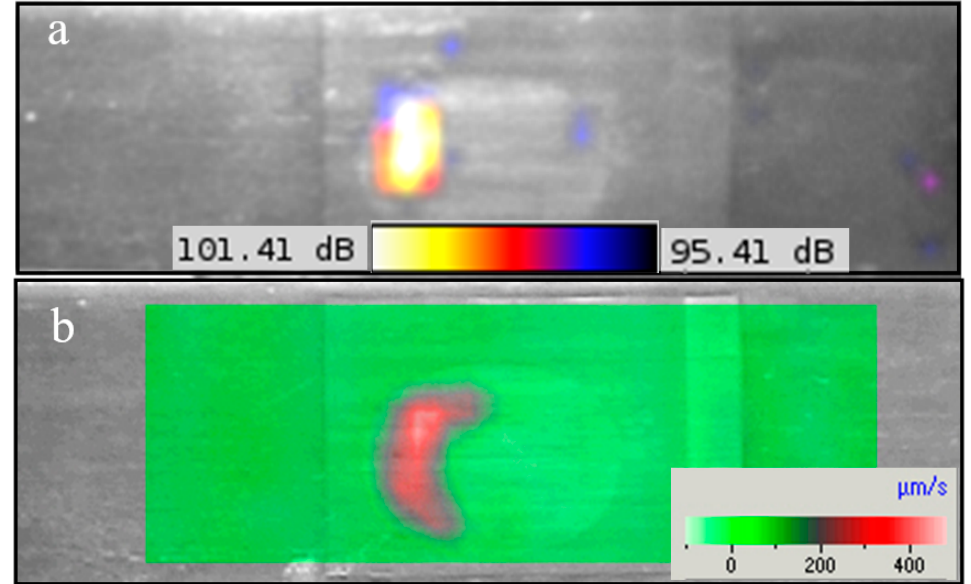
Figure 21. Soundcam imaging of a delamination in piezo-actuator imbedded in GFRP plate ( a ), 18,900 Hz LDR laser vi- brometry image of the delamination ( b